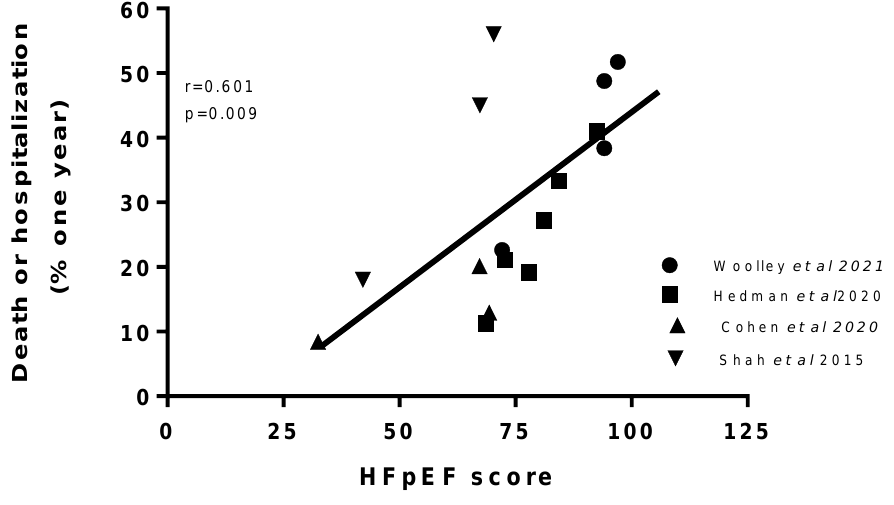
Figure 4: Correlation between the proposed HFpEF clinical score, in publications in which it could be calculated, and the one year